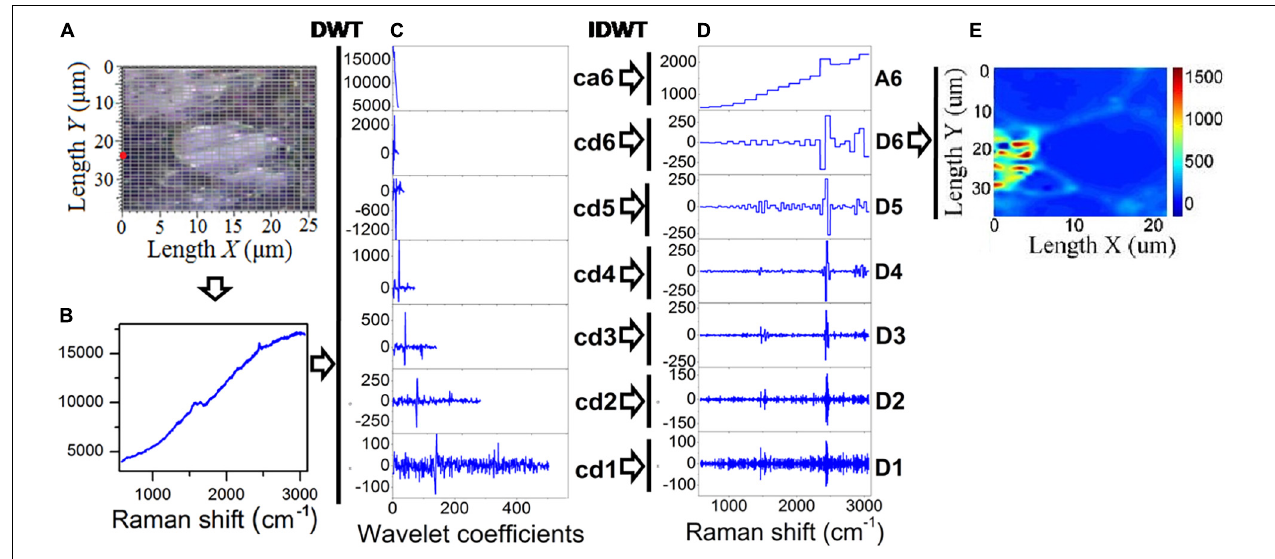
FIGURE 2 | DWT and IDWT data processing of Raman spectra. (A) Optical microscope image of tea tissue, (B) Raman spectroscopy of a sampling point, (C) wavelet decomposition coefficients, (D) wavelet reconstruction signals, and (E) chemical image generated from the reconstruction signal